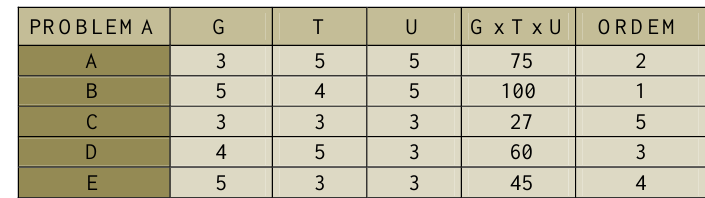
Tabela 7: Matriz GUT.